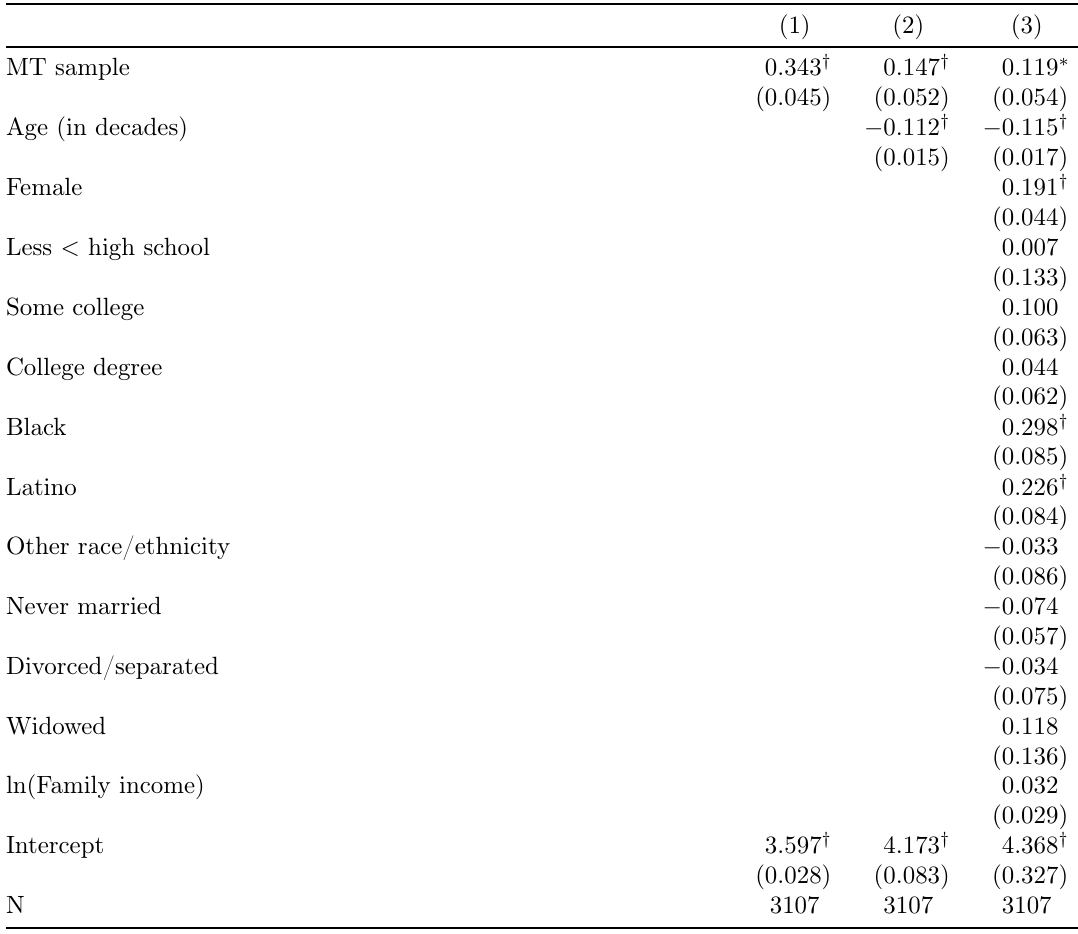
Table 3: OLS coefficients for regression of average response to sexual harassment vignette by sample, age, and selected